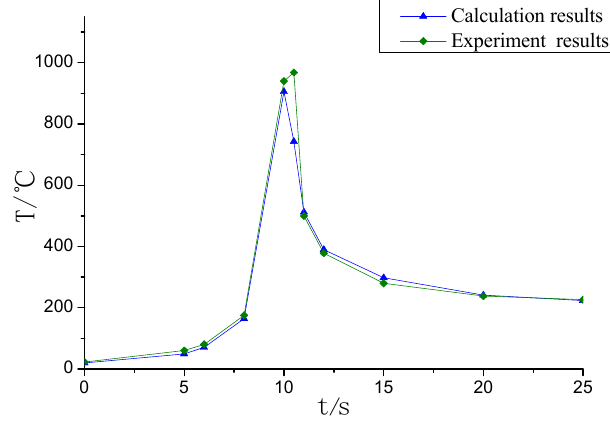
Figure 12. Comparison of thermal cycle curves of the calculation and experiment at point one.